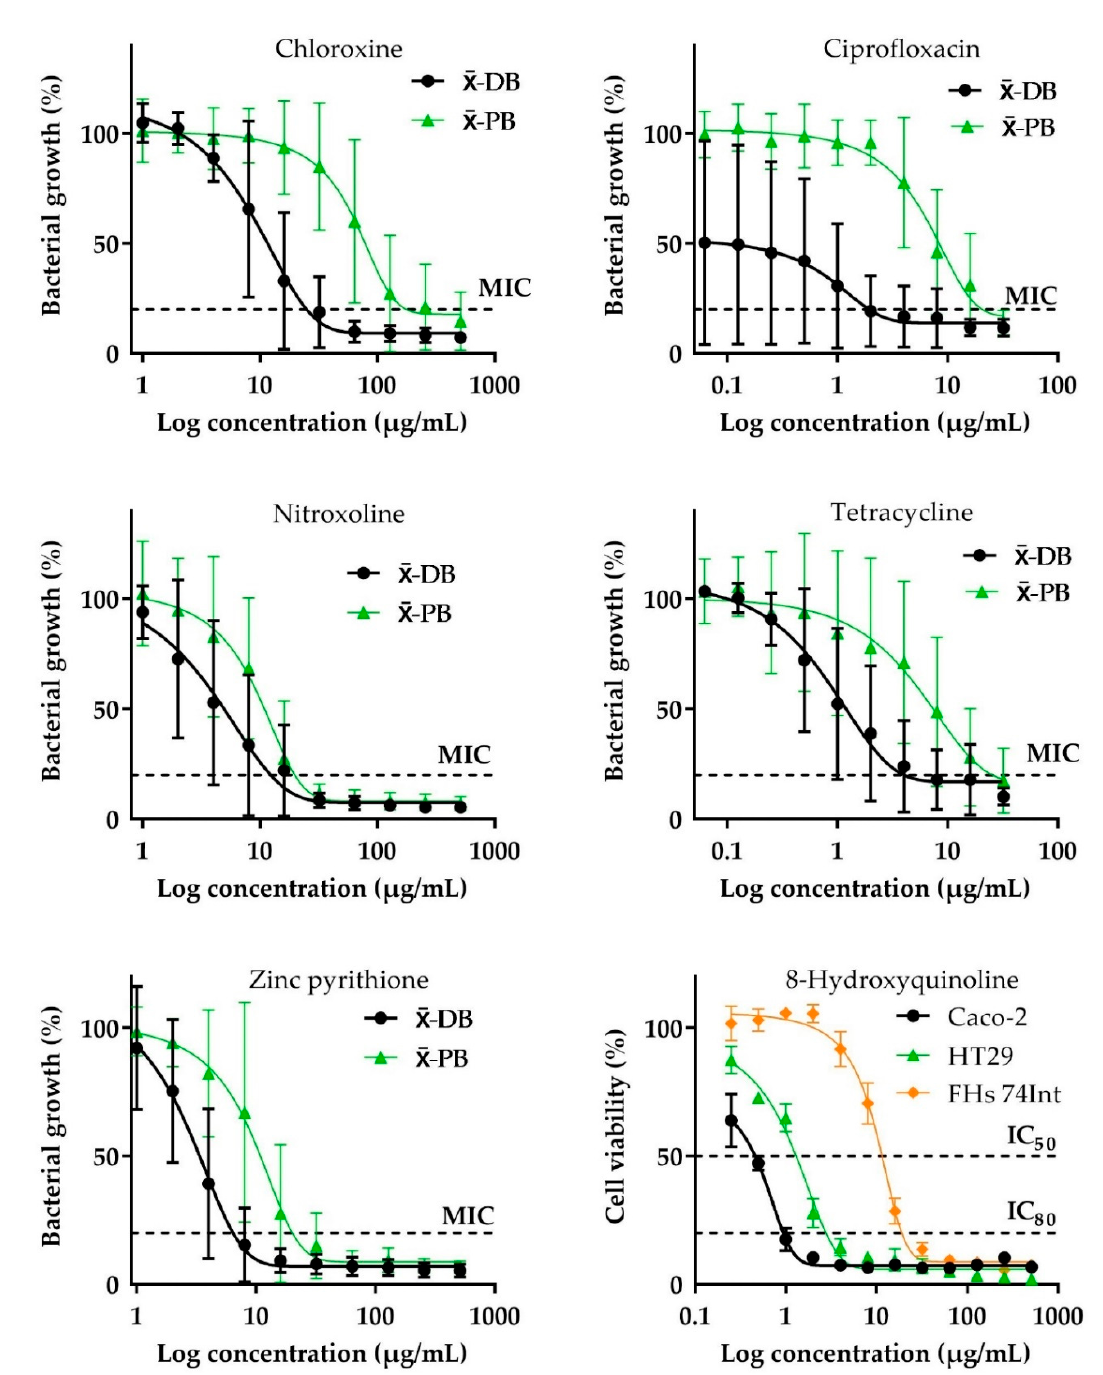
Figure 1. Selective concentration-dependent e ff ect of chloroxine, ciprofloxacin, nitroxoline, tetracycline, and zinc pyrithione on the growth of diarrheagenic and probiotic bacteria and of 8-hydroxyquinoline on intestinal normal and cancer cells proliferation in vitro. MIC: minimum inhibitory concentration; IC 50 : half maximal inhibitory concentration; IC 80 : 80% inhibitory concentration of proliferation. x -DB: mean MIC for 12 diarrheagenic bacteria, x -PB: mean MIC for 9 probiotic bacteria; Caco-2 and HT29: intestinal cancer cells; Fhs74 Int: intestinal normal cells.